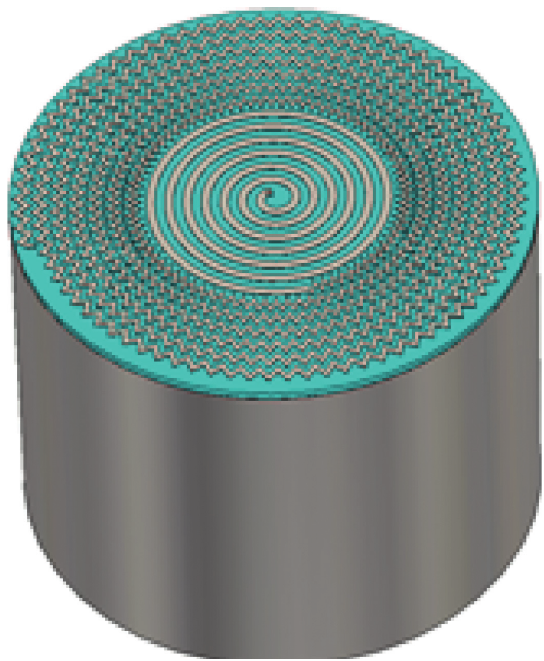
Figure 15: Simulated model of the SAAS antenna with a metallic